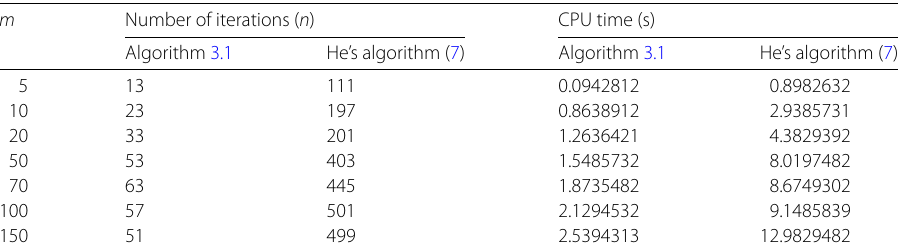
Table 1 Example 4.1: Comparison of Algorithm 3.1 with He’s algorithm (7) m Number of iterations ( n ) CPU time (s) Algorithm 3.1 He’s algorithm (7) Algorithm 3.1 He’s algorithm